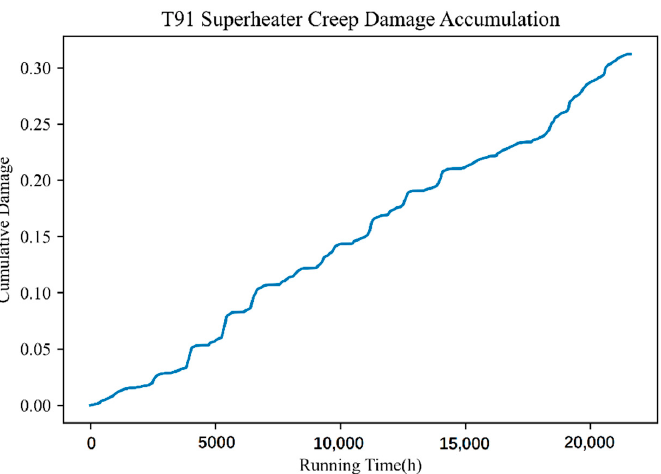
Figure 6. Relationship of service time and creep damage amount of final superheater T91 material.